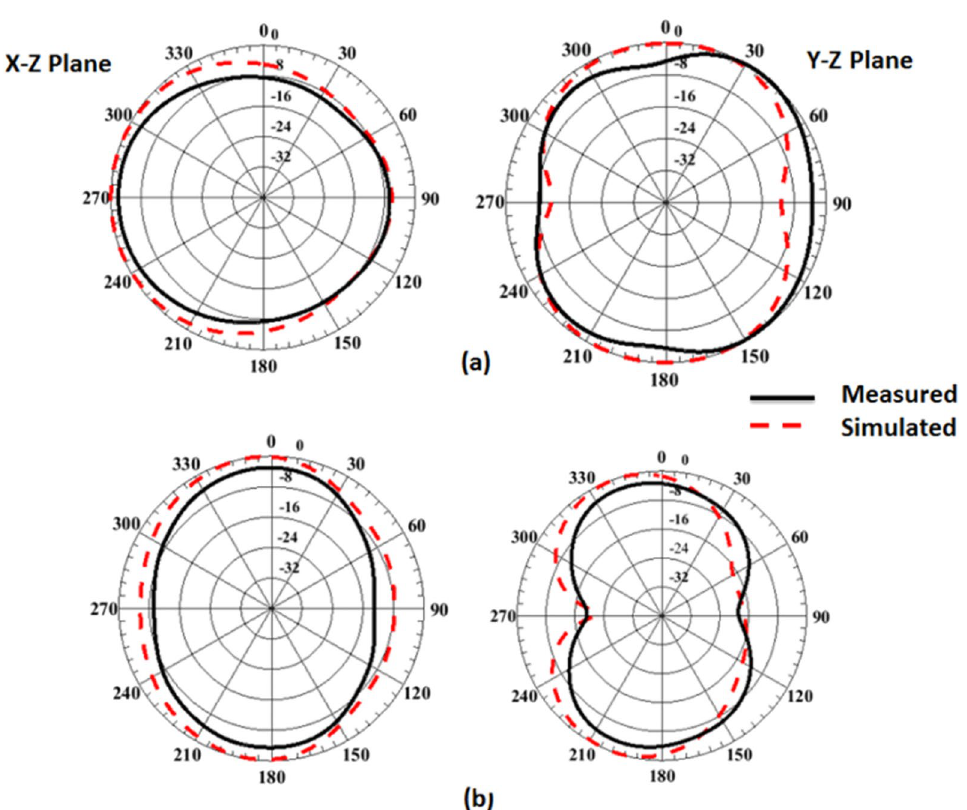
Figure 11. Port #1 radiation patterns simulated and testing outcomes of the flexible MIMO antenna in flat configuration ( a ) @4.5 GHz, ( b ) @ 8.5